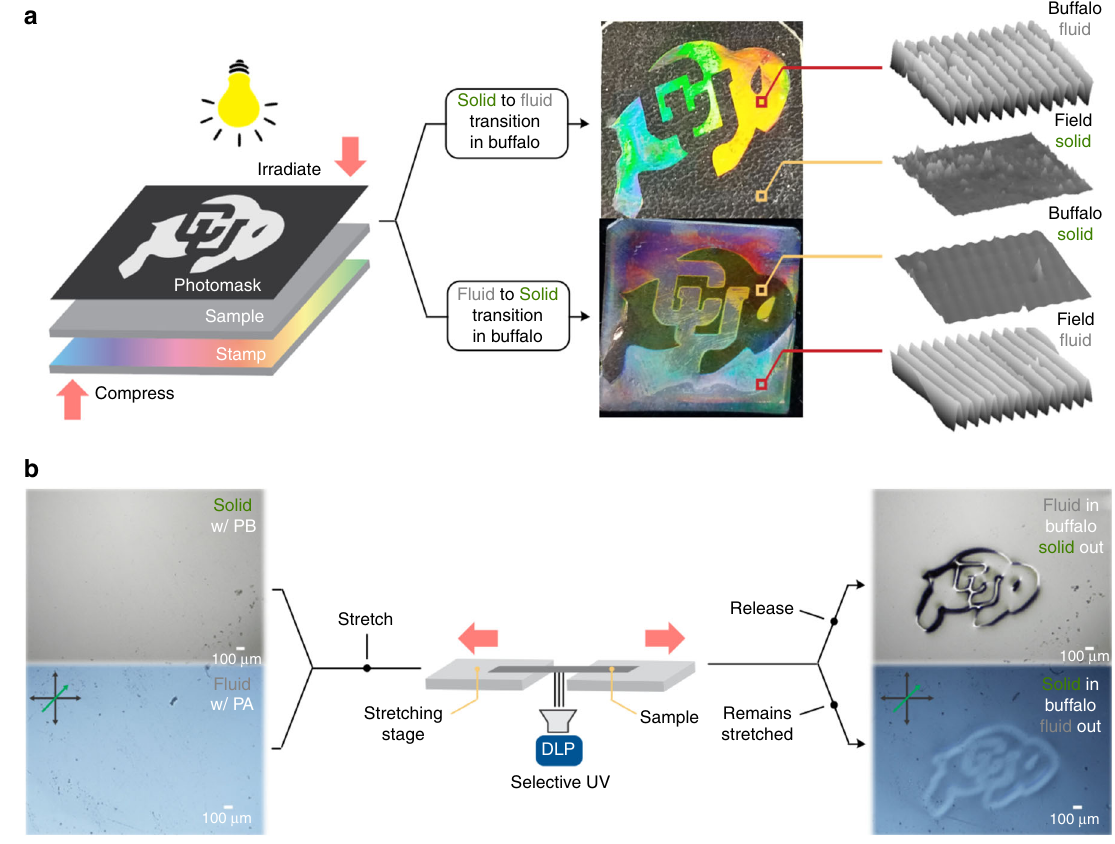
Fig. 4 Macroscopic and microscopic spatial control over plasticity. a Spatial control over phase at a macroscopic scale. A nano-scaled pattern (noted by the multi-colored sections) was transferred from a stamp to the sample via compression; exposure to light dictated whether the sample responded as a fl uid (top) or as a solid (bottom) in the unmasked, irradiated areas. b Spatial control over phase at a microscopic scale. Stretching under a microscope and irradiation with a DLP dictated whether the sample responded as a fl uid (top) or as a solid ( bottom ) in selected, irradiated areas. Top images for the fl uidizing formulation are bright fi eld microscope images (both images in a relaxed state) while the bottom images for the solidifying formulation